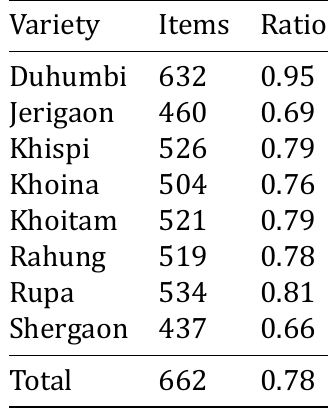
Table 2: Status of data coverage in Bodt’s Western Kho-Bwa data after initial fieldwork between 2012 and